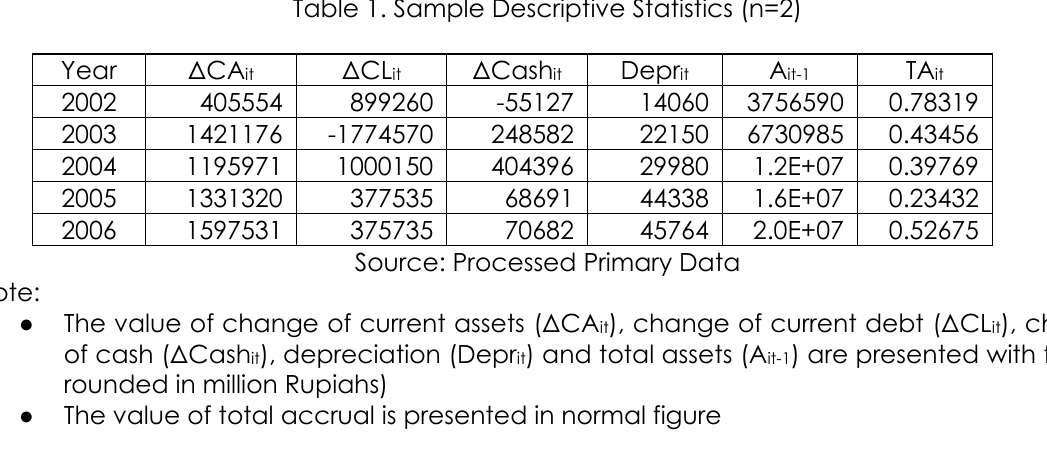
Table 1. Sample Descriptive Statistics